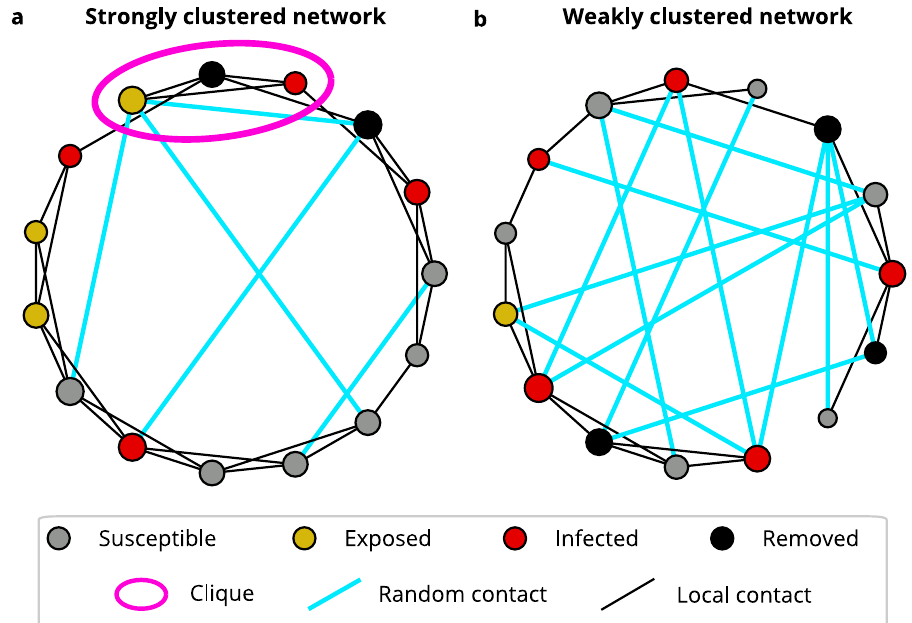
Figure 2. Watts–Strogatz small world network. Agents are placed in a ring-like topology and linked to their k nearest neighbors (black lines). Next, every link is rewired randomly with a small probability p (cyan lines). Every agent has one of four states: susceptible (gray), exposed (gold), infectious (red), or removed (black). Infectious agents spread the disease to connected susceptible agents with a probability p I in each time step. The size of network nodes is proportional to the node degree. ( a ) Strongly clustered network. Almost all contacts 0.1 ). ( b ) Weakly clustered network with a large fraction of random contacts are restricted to neighbors ( p = 15 agents, k 4 average 0.5 ). Other parameters are equal in ( a ) and ( b ): n ( p = = =